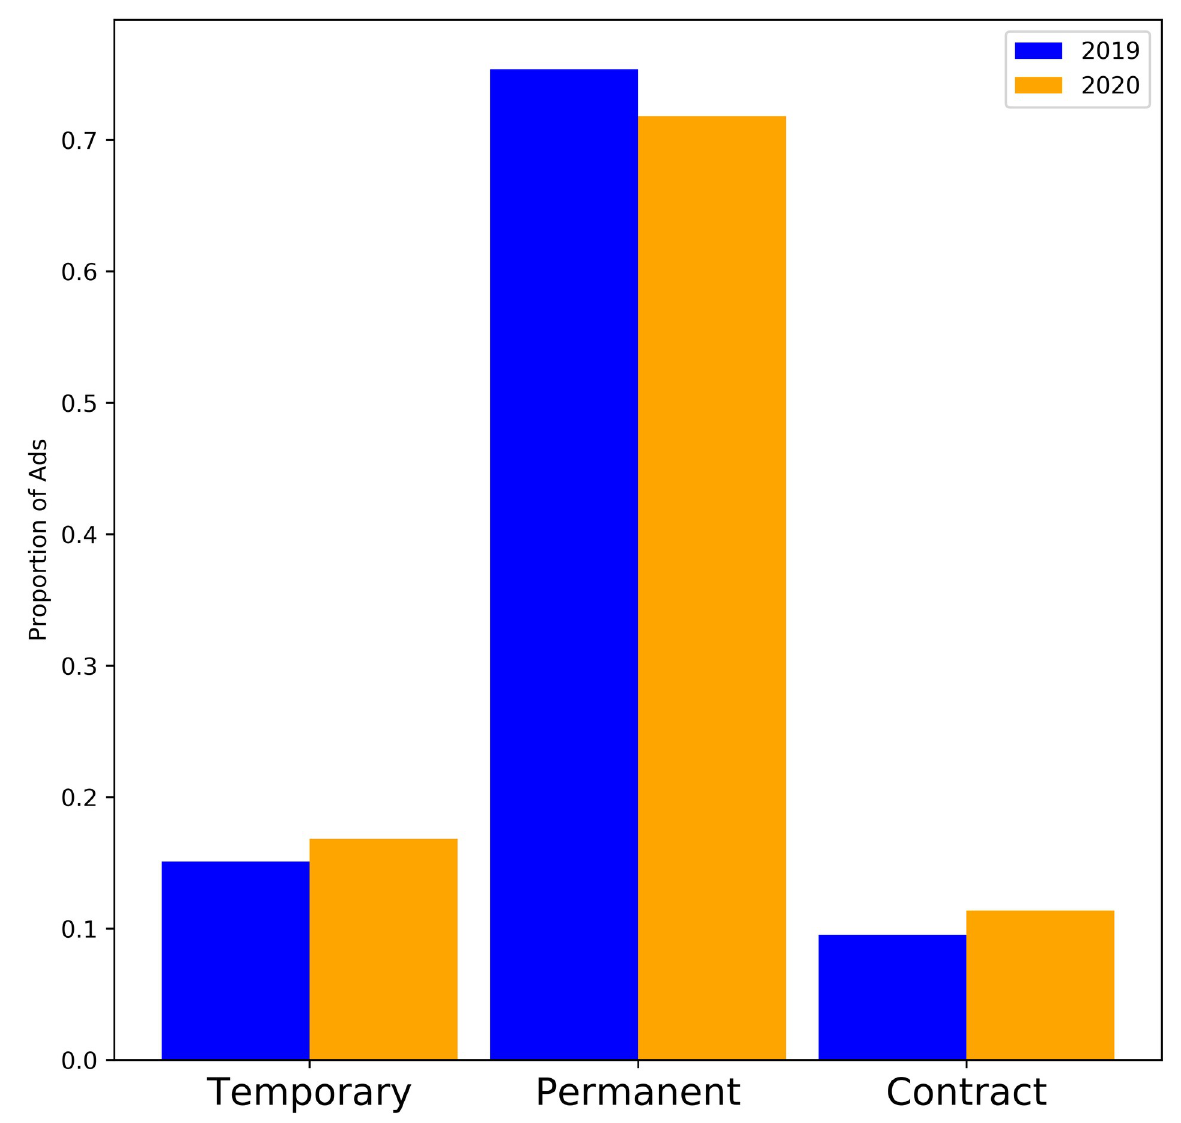
Fig 17. Proportion of job ads corresponding to three types of contract. Before Lockdown : Temporary: 15%, Permanent: 75%, Contract 10%. After Lockdown : Temporary: 17%, Permanent: 72%, Contract